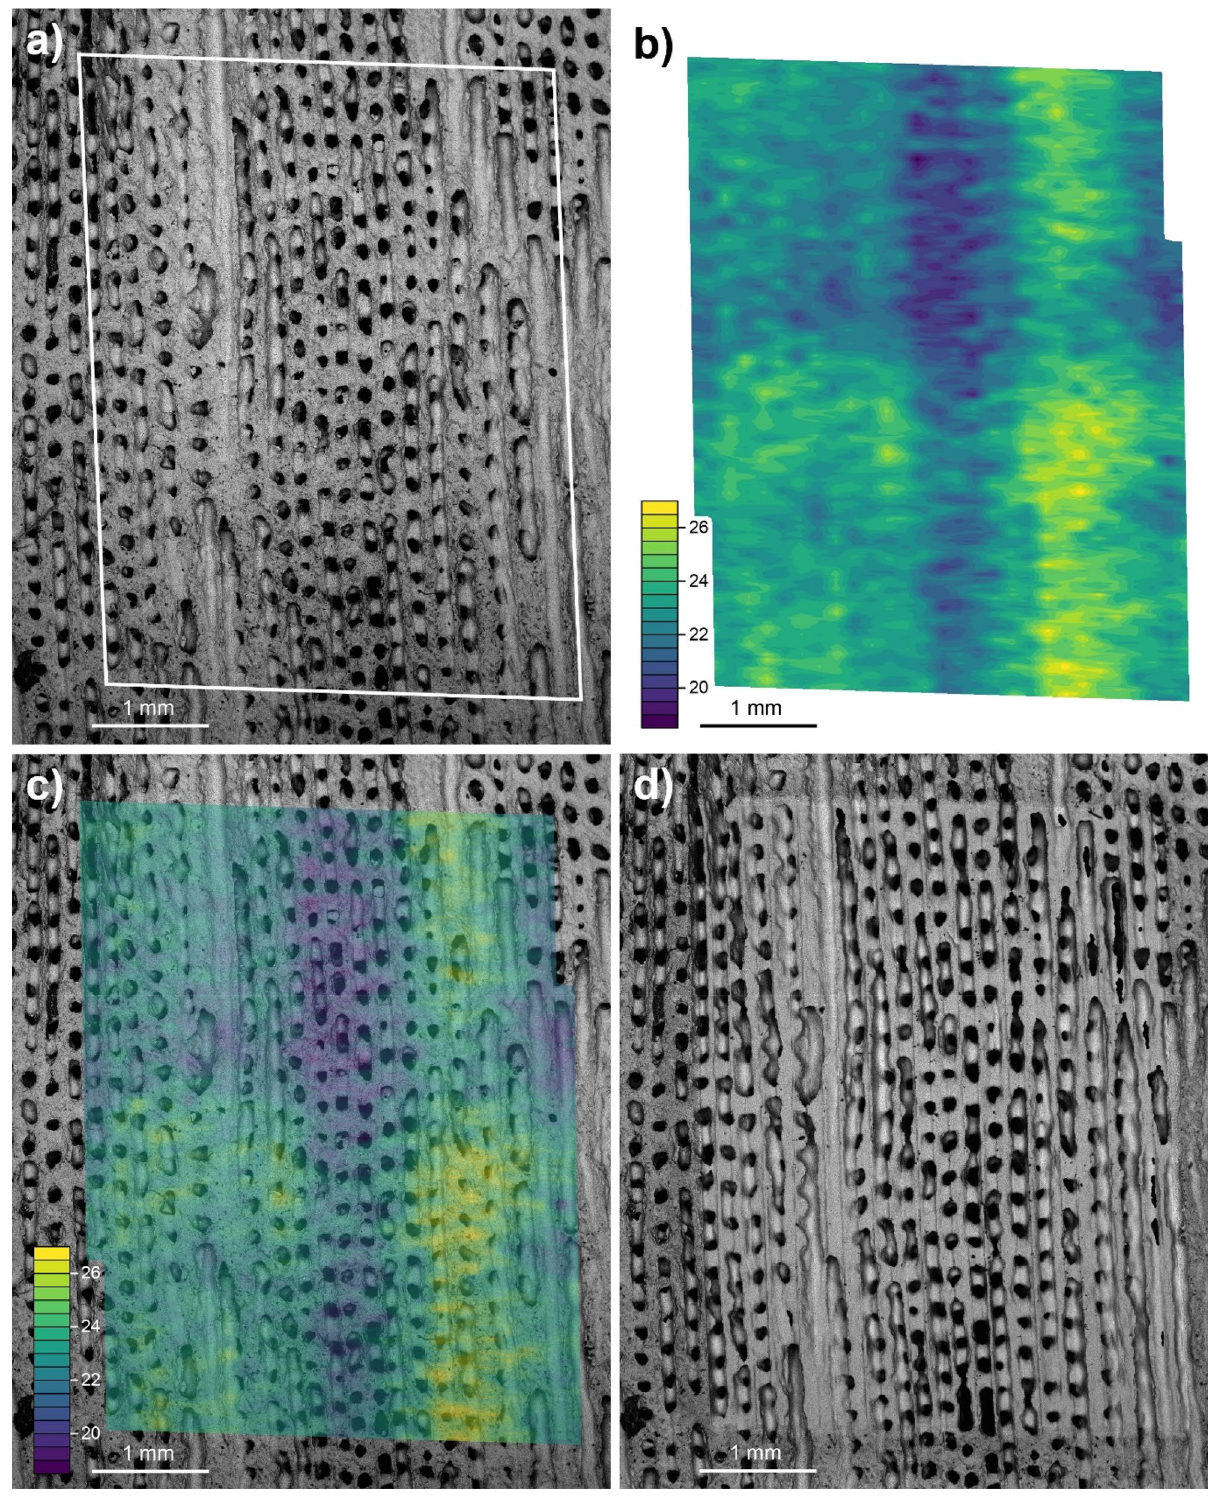
Figure 3. ( a ) Pre-ablation SEM image of the coral sector analysed by LA; ( b ) δ 11 B map of coral area, where yellow colours show high δ 11 B values (> 25‰), green colours show intermediary δ 11 B values (c.21–25‰) and blue colours show low δ 11 B values (< 21‰); ( c ) Overlay of δ 11 B map and SEM image, the values clearly match the structural elements of the coral with high values being confined to the polyp walls and low values to the columella. Sub-annual variability of ~ 1‰ is visible in the wall edges which may correspond to the dissepiments (not-visible). The two walls analysed show very similar trends but at different absolute values implying a potential 3-dimensional component to the analyses. ( d ) Post-ablation SEM image of the coral area